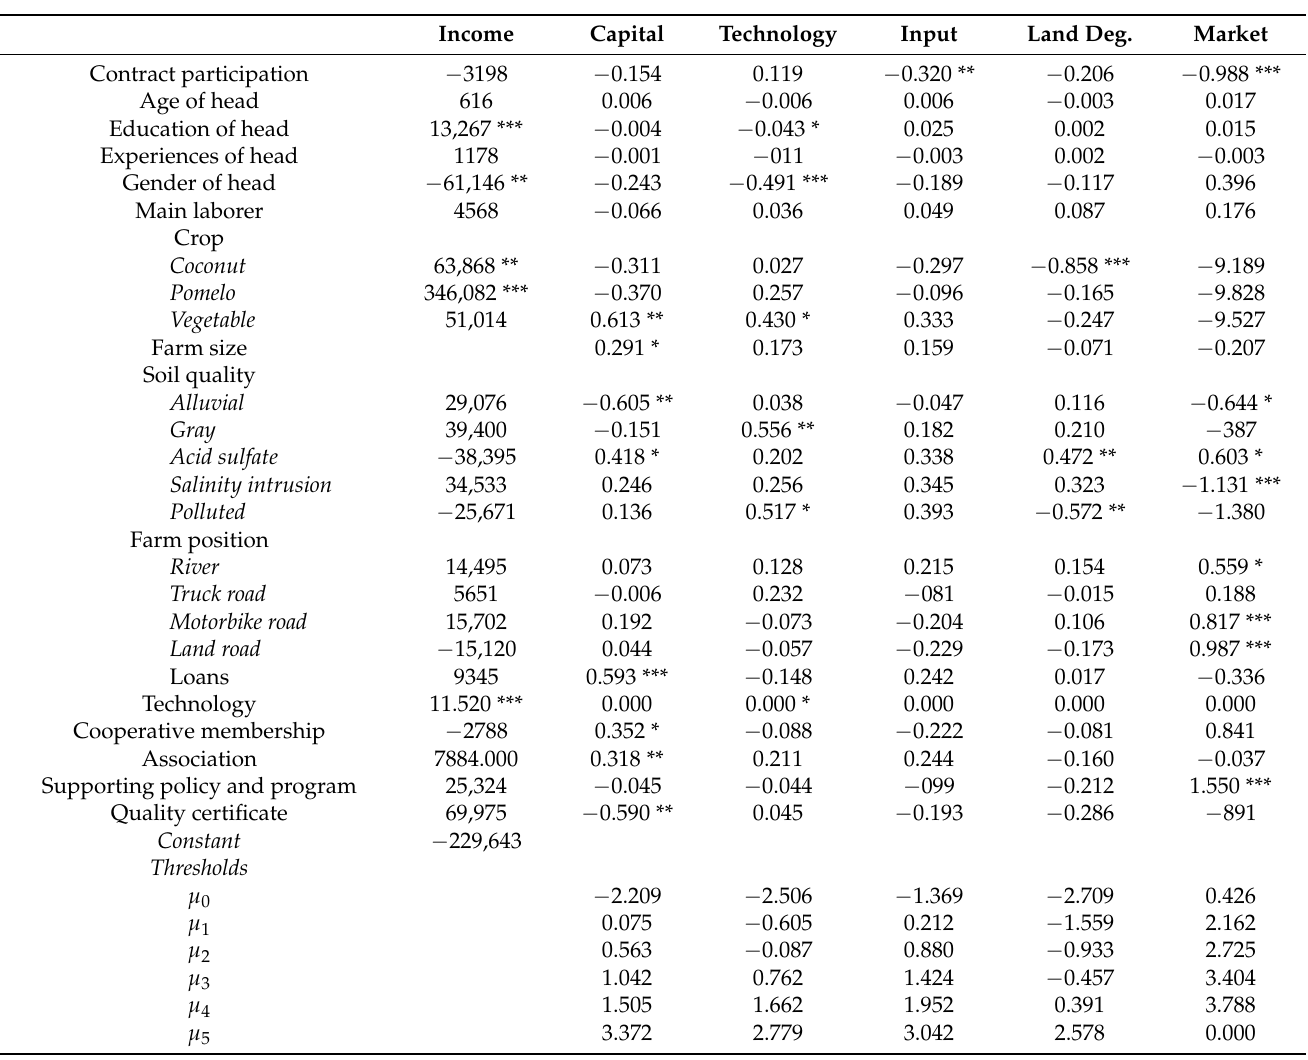
Table 3. Impact of contract farming on farmers’ income and farming activities. Income Capital Land